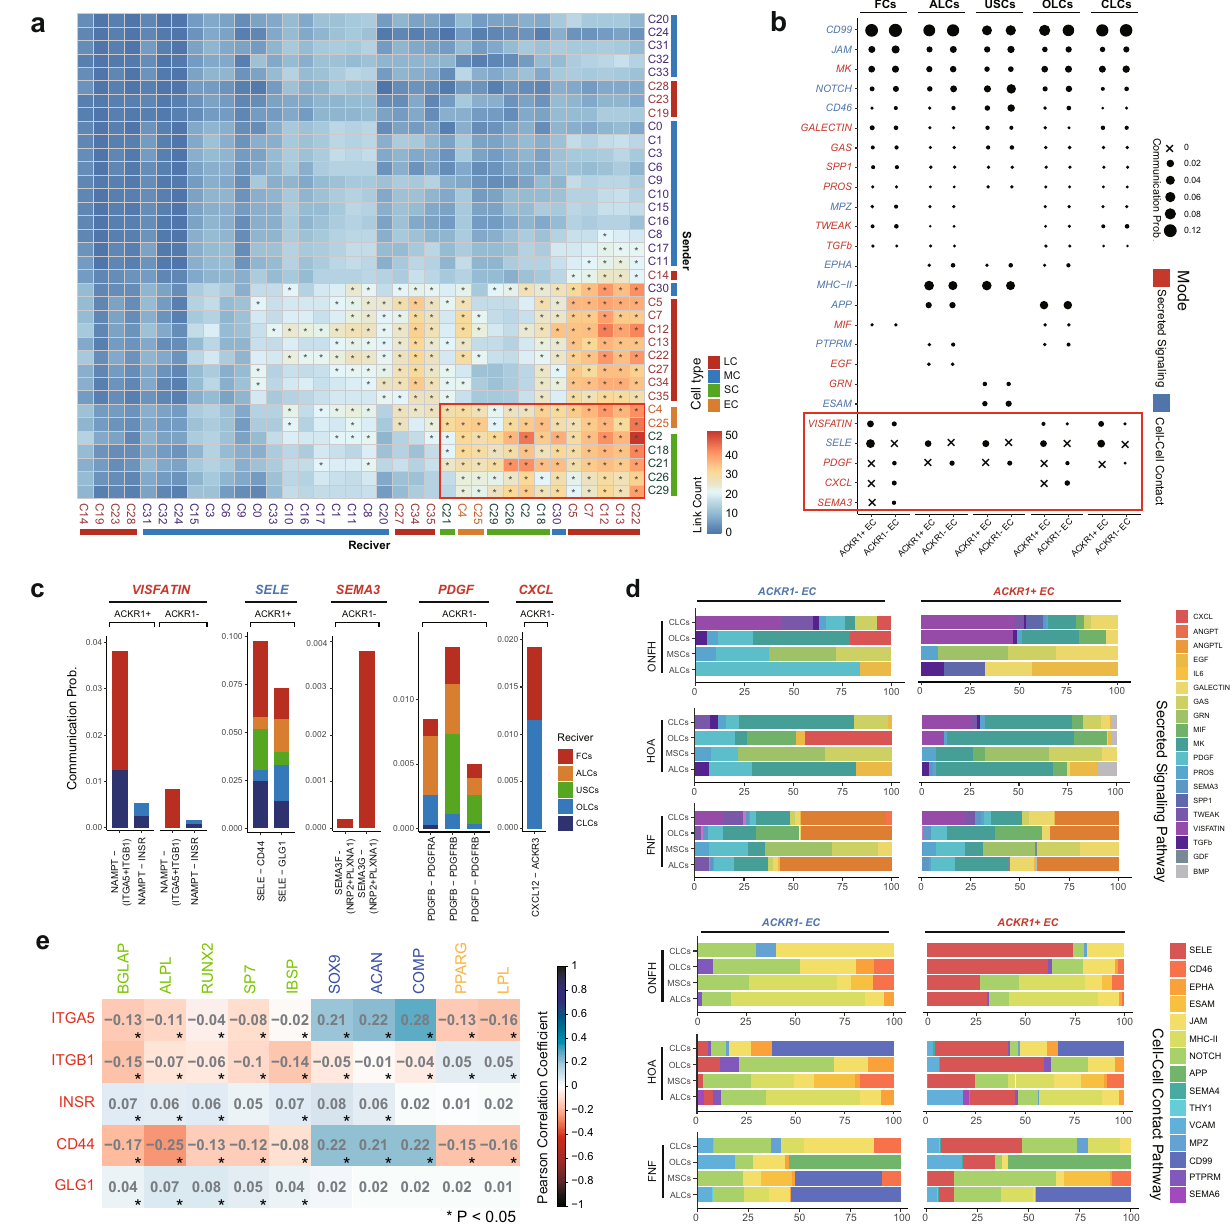
Fig. 6 Analysis of EC and SC communication indicated potential regulatory signalling pathways in alcohol-induced ONFH. a Heatmap showing the total counts of signi fi cant ligand-receptor pairs across all clusters in the ONFH group. The red frame indicates that EC, SC and myeloid cells harboured high-rank numbers of ligand-receptor pairs. b Bubble plot showing speci fi c interaction pathways among ECs and SCs. Pathways in the red frame were markedly different between ACKR1 + ECs and ACKR1- ECs. The bubble size represents the communication probability calculated by CellChat software. Pathway colour represents communication mode (secreted signal or cell – cell contact). c Bar plot showing the communication weights and distribution of ligands and receptors from pathways of interest. The colours in the bar column represent receiving cell groups. d Bar plot showing the proportions of communication pathways in different groups. The upper panel represents the secreted signalling pathway, and the lower panel represents the cell – cell contact pathway. The colours in the bar column represent communication pathways. e Pearson correlation analysis between pathway receptors of interest and adipogenesis or osteogenesis genes. Pearson-test, * P < Cell-to-cell communication analysis: All cell interaction analyses conducted in Analysis of transcriptional regulons: Regulon analysis was performed by using this study were performed using the R package CellChat. Both secretory the R package SCENIC and 3 basic packages, GENIE3, RcisTarget and AUCell. communication databases and cell-contact communication databases were used. First, we used GENIE3 to predict the gene coexpression network of the designated cell clusters. Then, we used RcisTarget to analyse the possible binding sites (motifs) of transcription factors in the target genes. Finally, we used AUCell to score the activity of regulons in each group. After the above preparation, we used SCENIC to Cell culture and isolation . The cell suspension obtained via the above method was further extract and analyse the results and evaluated the RSSs and activities of the also used for endothelial cell culture and MSC culture. To culture endothelial cells, regulons. regional cells were seeded in 100 mm cell culture dishes at a density of 50,000/cm 2